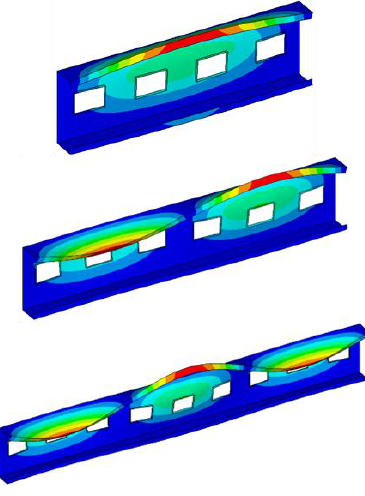
Figure 9. Typical distortional buckling modes.